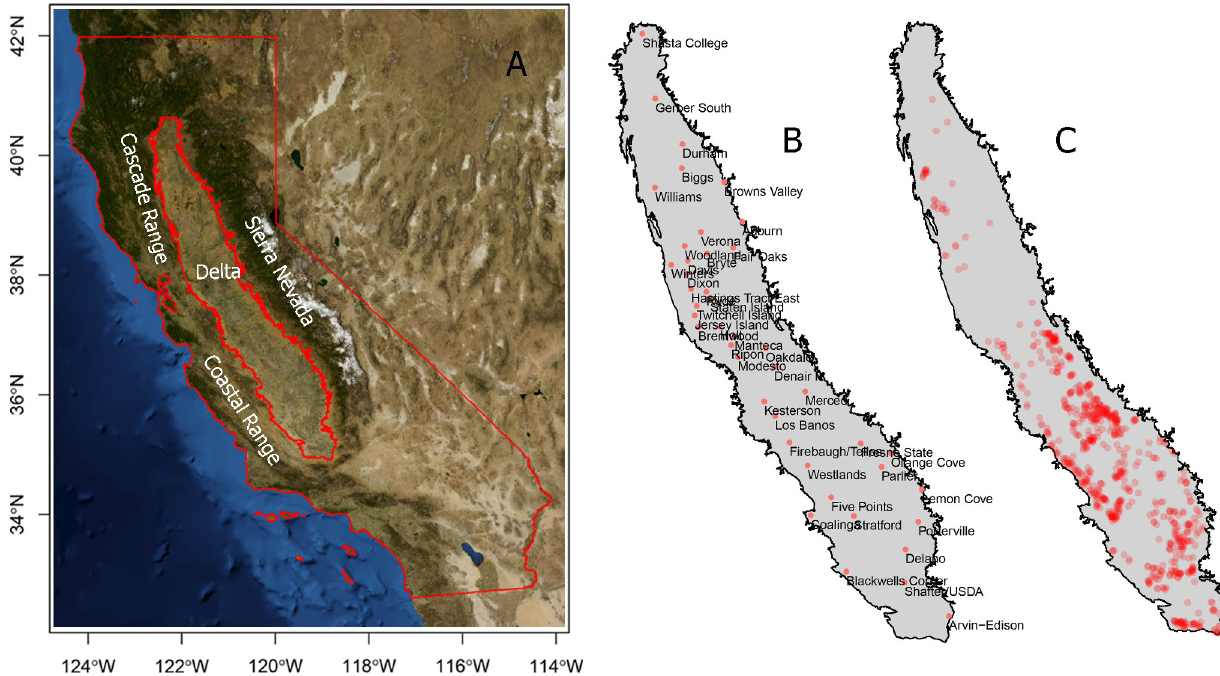
Fig 1. Overview of California’s central valley showing some landmarks such as mountain ranges and the Sacramento-San Joaquin river delta for reference purposes (USGS National Map Viewer; A), the location and name of the CIMIS stations (B) and the location of the in-orchard weather stations (C).